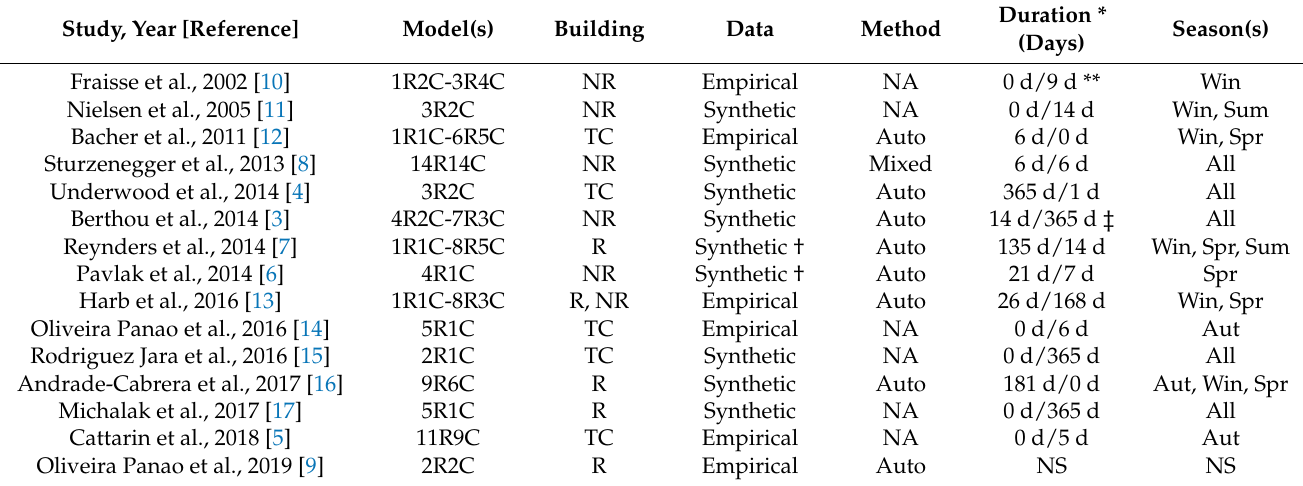
Table 1. Review of GB models used for predicting internal air